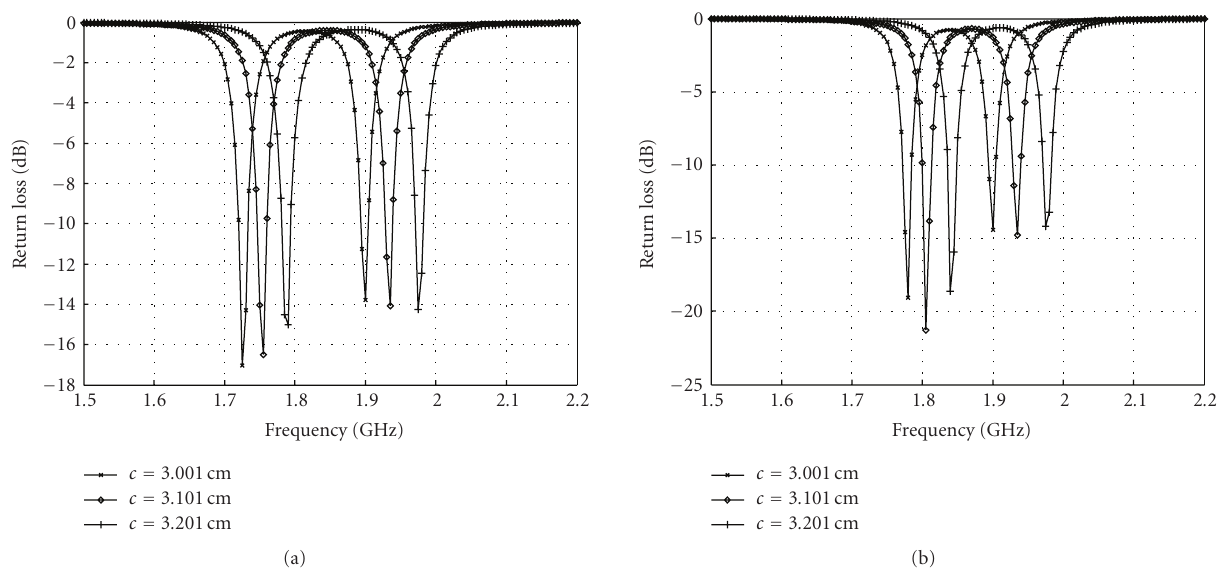
Figure 5: (a) Variation of return loss with frequency for di ff erent feed location at S = 0.095 cm. (b) Variation of return loss with frequency for di ff erent feed location at S = 0.11 cm.